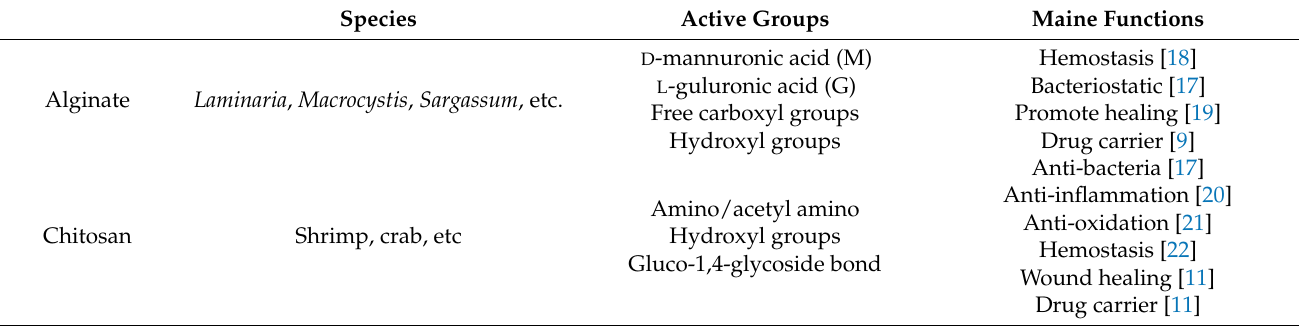
Table 1. Main active groups, functions, and sources of three